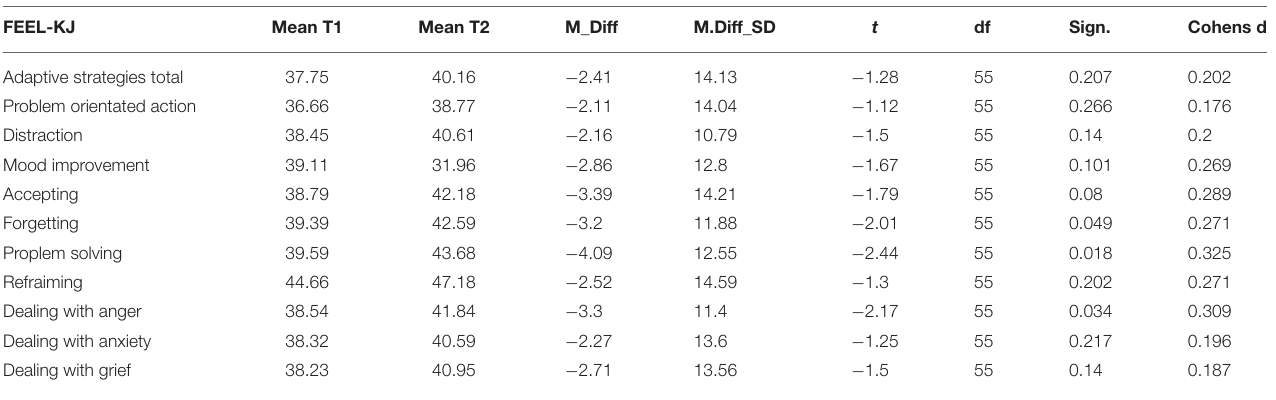
TABLE 2 | FEEL-KJ adaptive